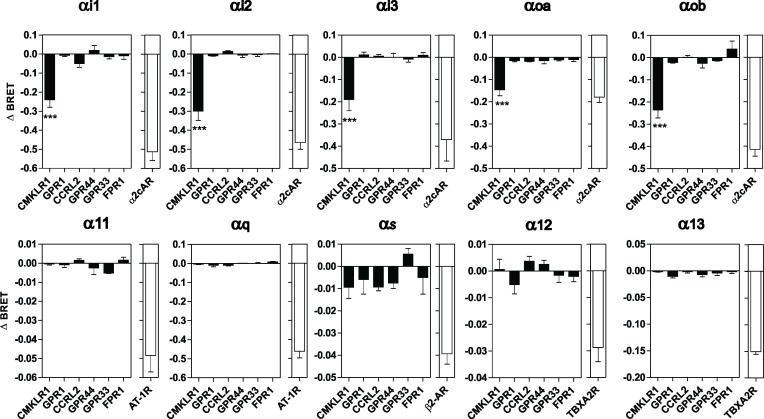
Determination of the range of G proteins activated by chemerin receptors.Real-time measurement of BRET signal in HEK293T cells coexpressing G protein biosensors and CMKLR1, GPR1, CCRL2, GPR44, GPR33 or FPR1, following stimulation for 1 minute by 100 nM chemerin. Results are expressed as the difference in BRET signals measured in the presence and absence of chemerin. As controls, cells expressing the α2c adrenergic receptor (Gαi/o) were stimulated with UK14304; cells expressing the AT1 angiotensin receptor (Gα11/q) were stimulated with angiotensin II; cells expressing the β2 adrenergic receptor (Gαs) were stimulated with isoproterenol; cells expressing thromboxane A2 receptor (Gα12/13) were stimulated with U46619. Data represent the mean ± S.E.M. of three to six independent experiments. Statistical significance was assessed using Tukey's test (***P < 0.0001).